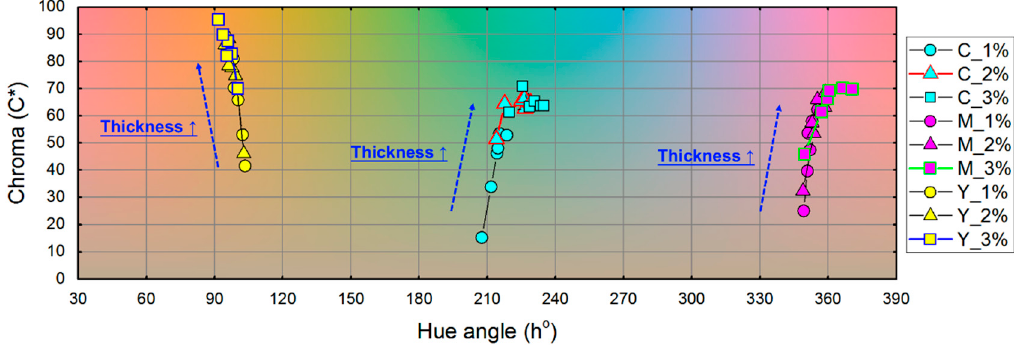
Figure 7. Hue angle (h)-chroma (C*) diagram of the prepared resins in CMY colors.